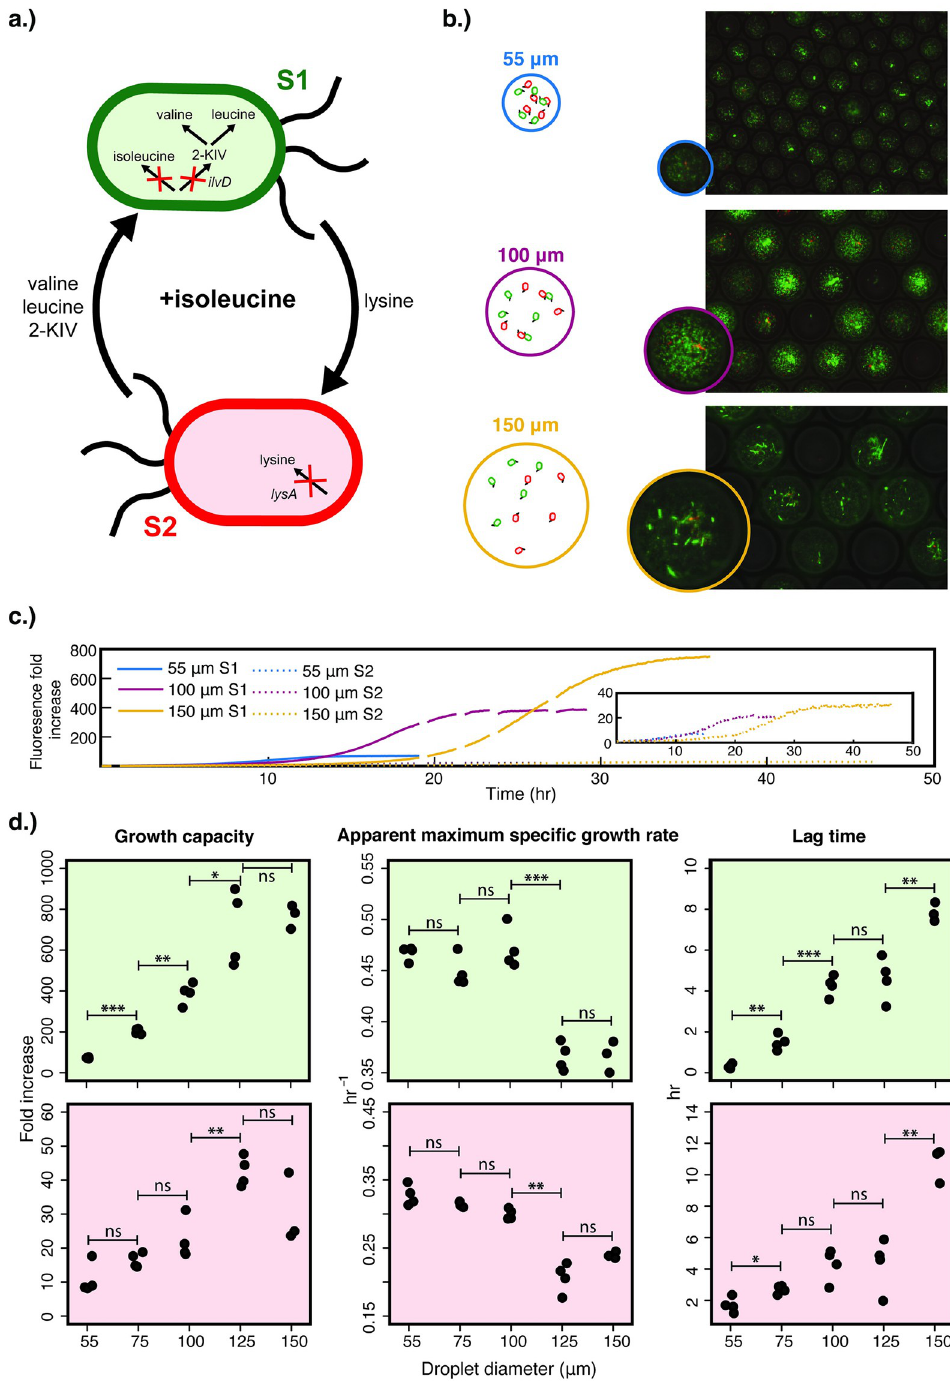
Fig 3. Co-growth of S1 Δ ilvD and S2 Δ lysA under the low degree of interaction (with supplementation of 3 mM isoleucine, the most biosynthetically-expensive cross-fed amino acid) in a range of droplet sizes with λ = 5 cells/ droplet. (a) The cross-feeding between S1 Δ ilvD and S2 Δ lysA under isoleucine supplementation. (b) Fluorescence microscopy and phase contrast overlays of droplets of 55, 100, and 150 μ m after co-cultivation, with representative images illustrating the bi-culture densities. S1 Δ ilvD has a constitutively-expressed mNeonGreen (green) fluorescence reporter and S2 Δ lysA has a constitutively-expressed mCherry (red) fluorescence reporter on a plasmid. (c) Average growth curves of the bi-culture. For each droplet size, there are two growth curves, for S1 Δ ilvD (bold line) and S2 Δ lysA (dotted line), respectively. Each curve represents the average growth of the strain in co-culture across multiple wells in a